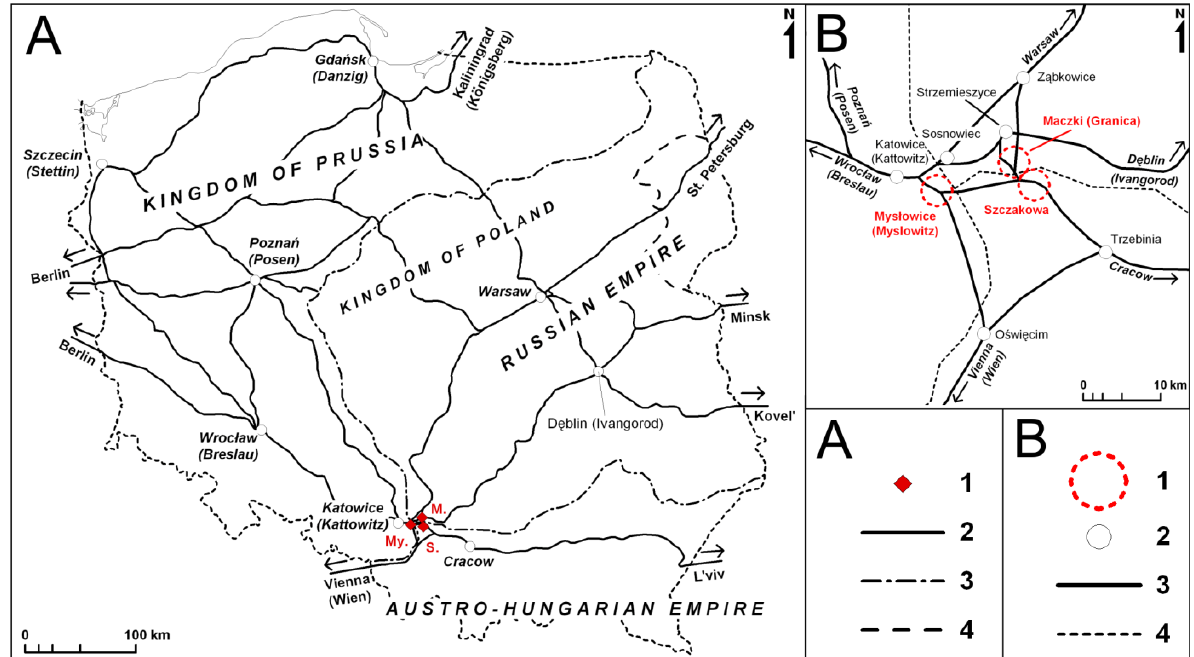
Fig. 1. Location of the case study towns against the background of contemporary and partitioning boundaries(A) and the railway network in their proximity